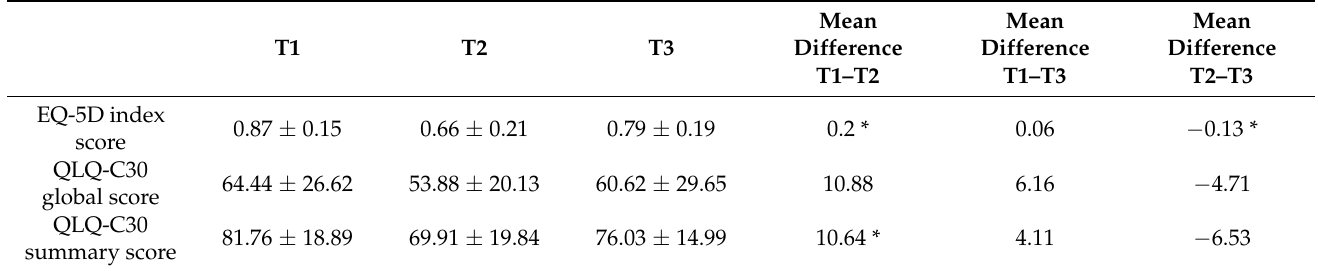
Table 3. Differences in clinical data at the different time points: preoperative one month (T1), postoperative three days (T2) and postoperative one month